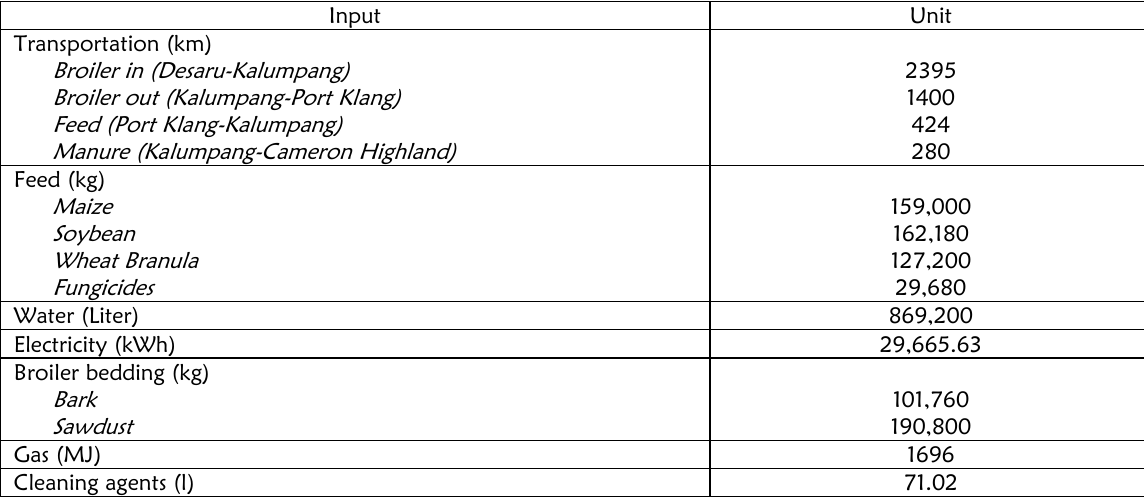
Table 3: Inventory data of inputs in the broiler farm.